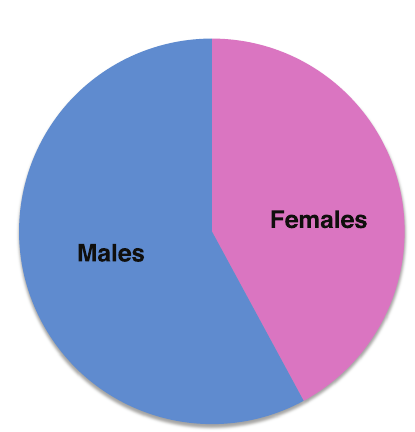
Figure S2. Gender distribution of the surveyed